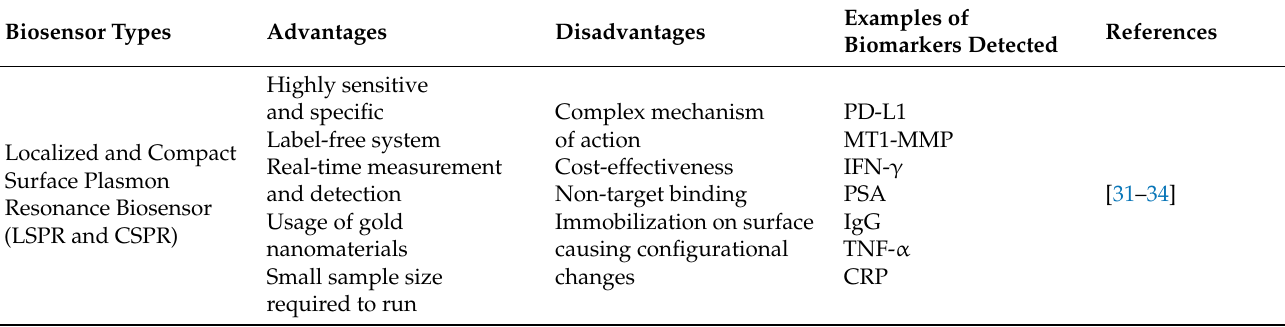
Table 2. List of Different Biosensors, their Advantages and Limitations and their Potential Biomarker Targets. Biosensor